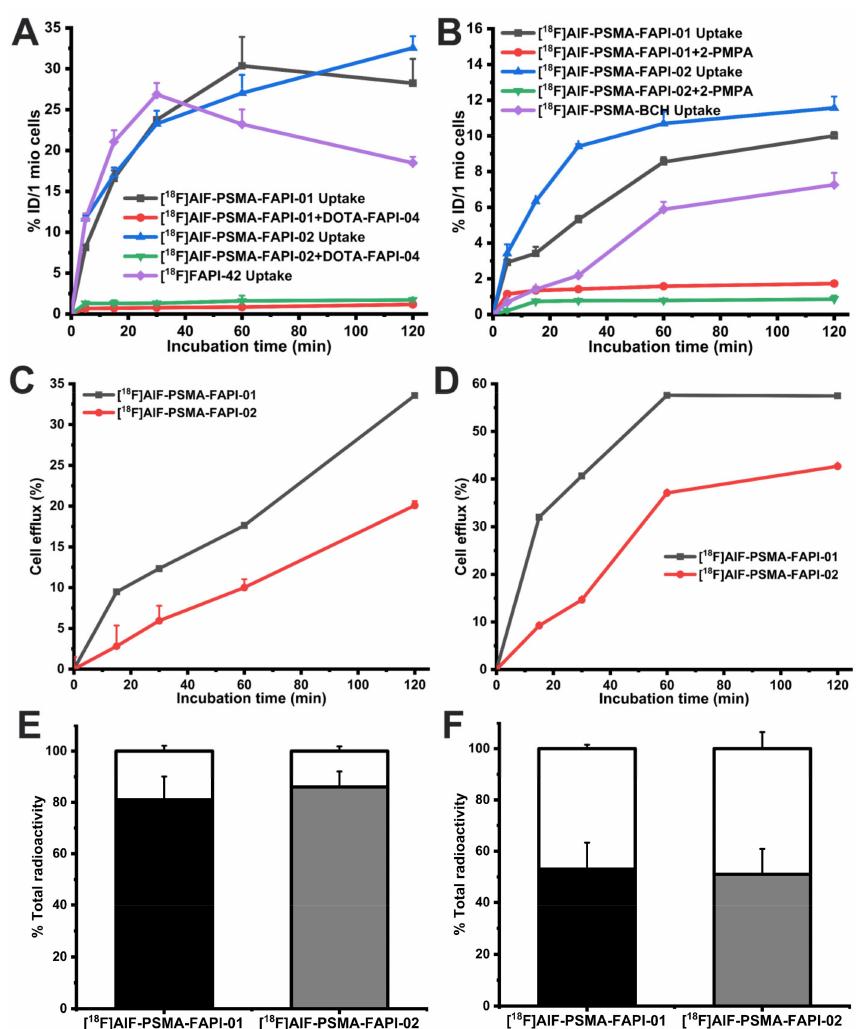
Figure 4. In vitro cell uptake and blocking study results of [ 18 F]AlF-PSMA-FAPI-01, [ 18 F]AlF-PSMA- FAPI-02, and corresponding monomeric tracer [ 18 F]FAPI-42 or [ 18 F]AlF-PSMA-BCH in A549-FAP cells ( A ) and 22Rv1 cells ( B ). Efflux kinetics of [ 18 F]AlF-PSMA-FAPI-01 and [ 18 F]AlF-PSMA-FAPI-02 after 60 min incubation of A549-FAP cells ( C ) and 22Rv1 cells ( D ) with tracers followed by incubation with compound-free medium for 15–120 min. Values indicate the mean ± SD ( n = 6). Internalized and membrane-bound [ 18 F]AlF-PSMA-FAPI-01 and [ 18 F]AlF-PSMA-FAPI-02 in A549-FAP ( E ) and 22Rv1 cells ( F ) after incubation for 60 min. The black and grey segments represent the internalized proportions, while the blank segments indicate the membrane-bound